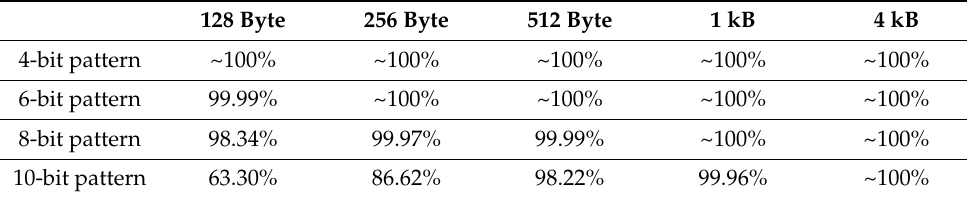
Table 1. Probability of finding n-bit pattern in an m-bit cover